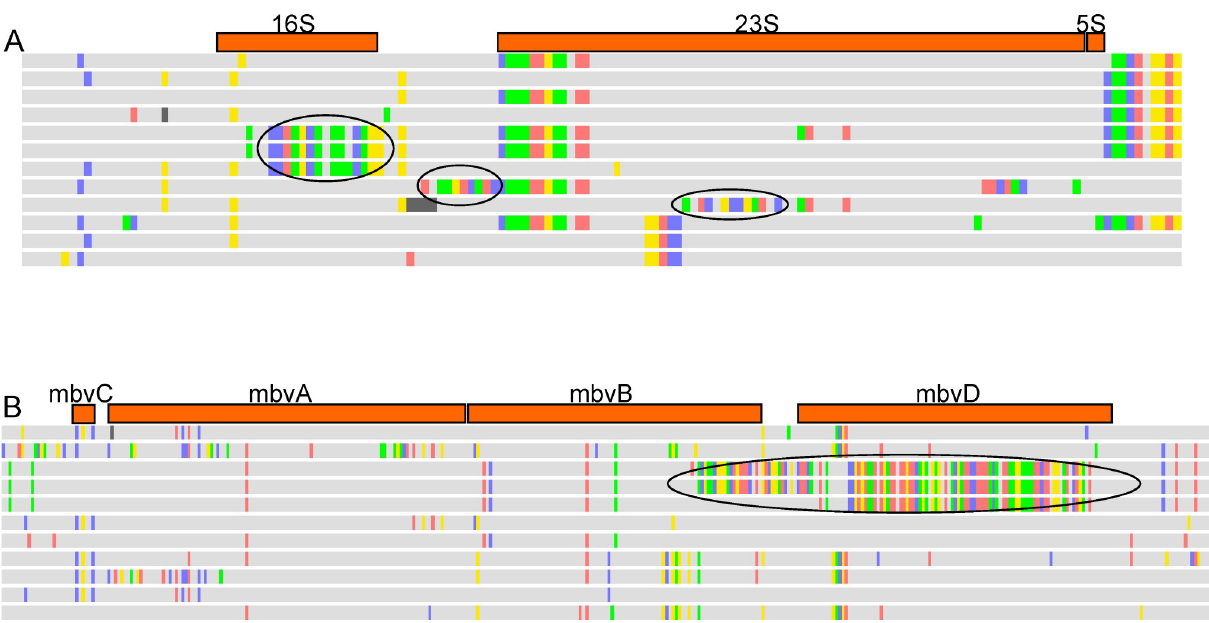
Fig 3. Partial Moraxella bovoculi single nucleotide polymorphism (SNP) alignments of A) a rRNA locus and B) the RTX locus with constituent genes appearing as orange bars above alignments. Multi-colored SNP blocks (circled) are highly divergent from the grey consensus sequence and hypothesized to be interspecies mosaics. Confirmed recombinants via BLAST are listed in Table 2.